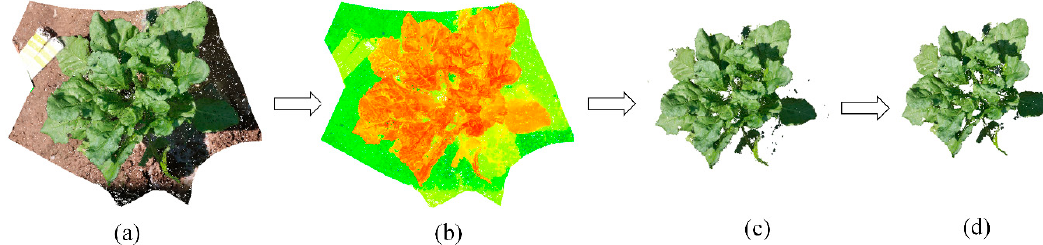
Figure 5. Performance of filtering: ( a ) Point cloud of individual plant after coordinate correction; ( b ) G-R color distribution of point cloud; points with dark green represent soils; points with light green represent shadows; points with orange represents plant; ( c ) Point cloud of individual plant after color filtering; ( d ) Point cloud of individual plant after statistical filtering.